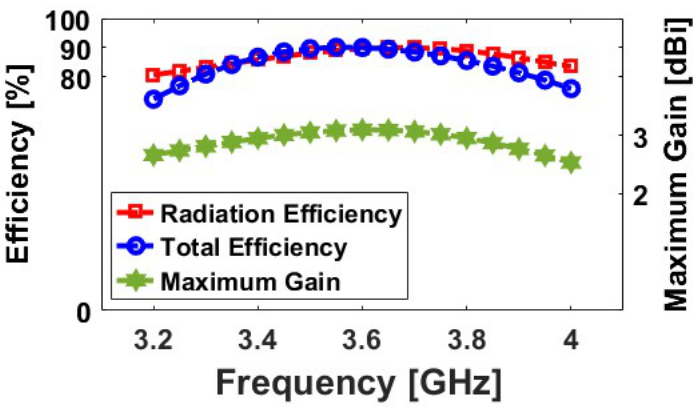
Figure 5. 3D views of the dual-polarized radiation patterns from ( a ) feeding port 1 and ( b ) feeding port 2.